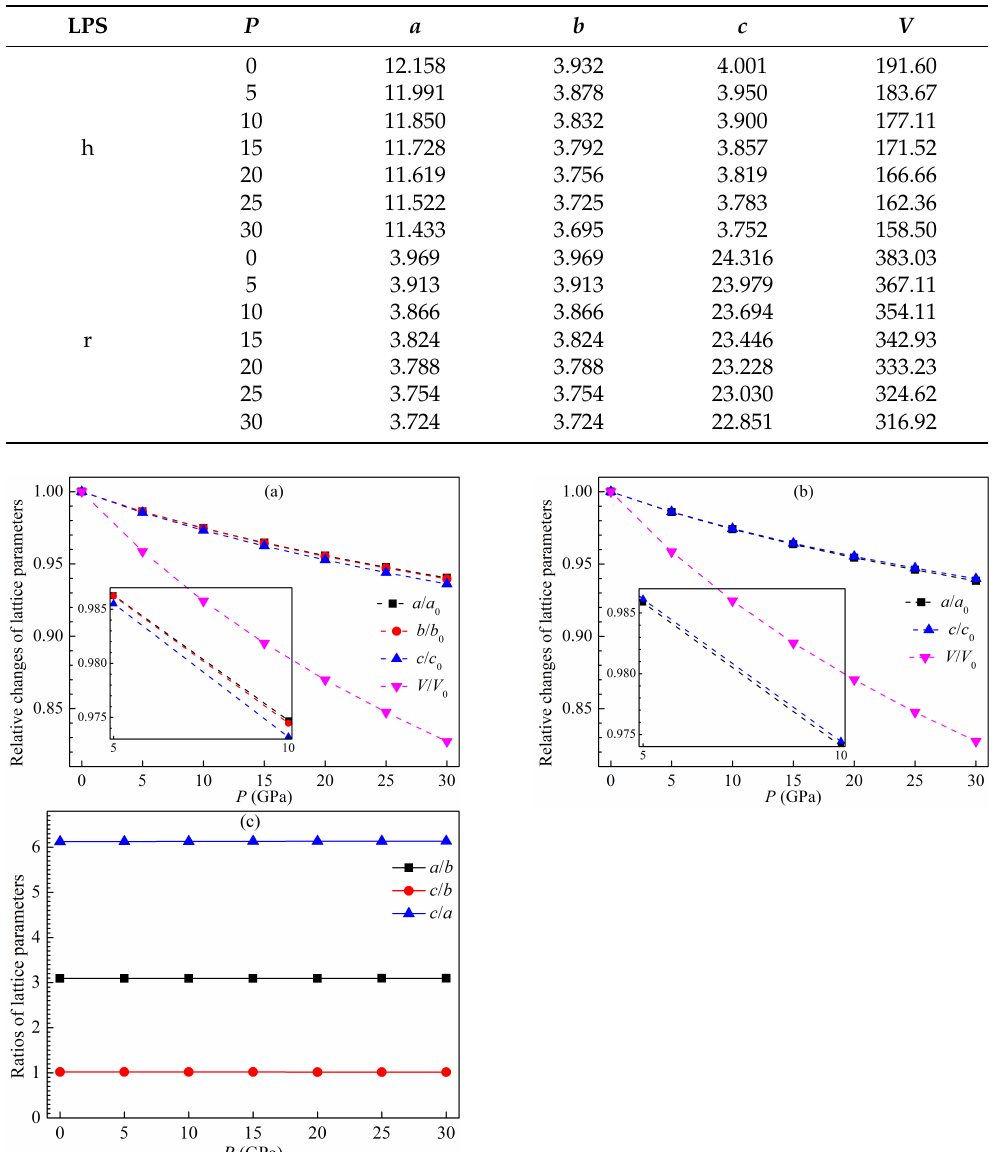
Table 2. Optimized lattice parameters a , b and c (in Å) and volumes of unit cell V (in Å 3 ) for the LPSs h- and r-Al 2 Ti under pressure up to 30 GPa at 0 K.